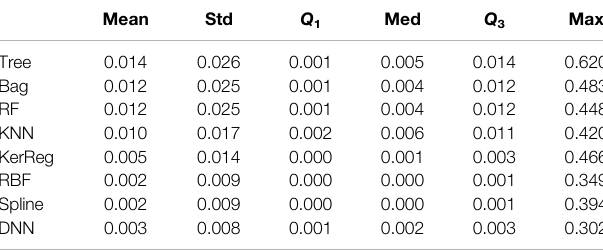
TABLE 4 | Performances of all the methods trained on TRAIN_M13 and tested on TEST_M13. We consider the absolute error | e i | and report the mean error, standard deviation, fi rst quartile, median error, third quartile, and maximal error.